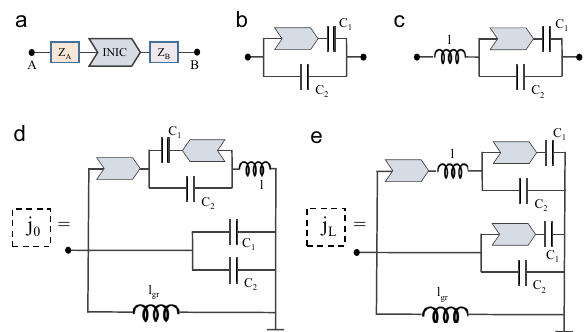
Fig. 6 Details of the circuit realization. a Two generic elements with impedances Z A , Z B connected in series at either side of a negative impedance converter with current inversion (INIC) (elaborated in ref. 48 ) give rise to a non-Hermitian Laplacian Eq. (33). b Asymmetric couplings of the simplest form (Eq. (34)) can be realized with a parallel con fi guration containing one INIC and two capacitors. c An impurity bond consisting of tunable equivalently rescaled asymmetric couplings (Eq. (36)) can be realized with a variable inductor l connected in series with J NN . d , e Explicit example realizations of j 0 , j L grounding components needed to make the grounding terms of the impurity nodes equivalent to the others ’ . Changing the AC frequency ω leads to a uniform shift in Laplacian eigenvalues through ð i ω l gr Þ (cid:2) 1